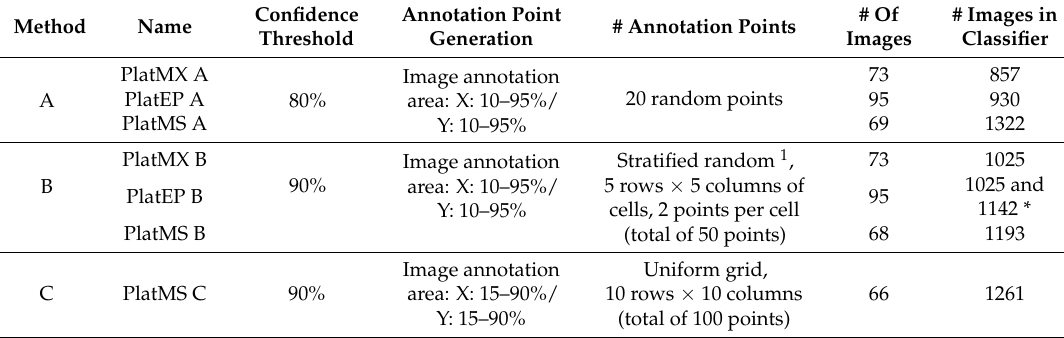
Table 2. Outline of the three testing methods: confidence threshold, annotation area, number and layout of annotation points, number of images from platform and the number of images trained in the classifier. [#: number